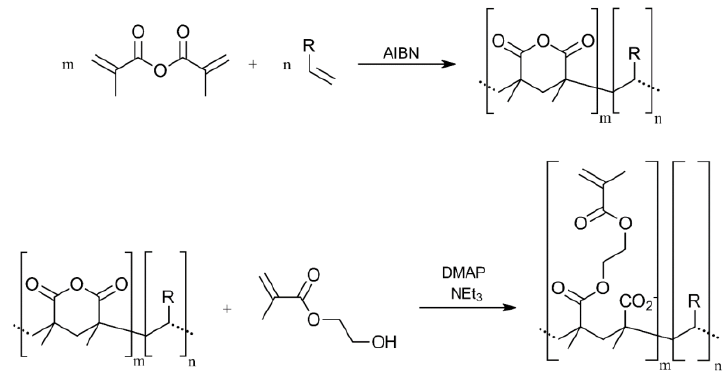
Figure 2. Synthesis of reactive MAAA- copolymer and subsequent hydrolysis with HEMA to receive a crosslinker (298 K).